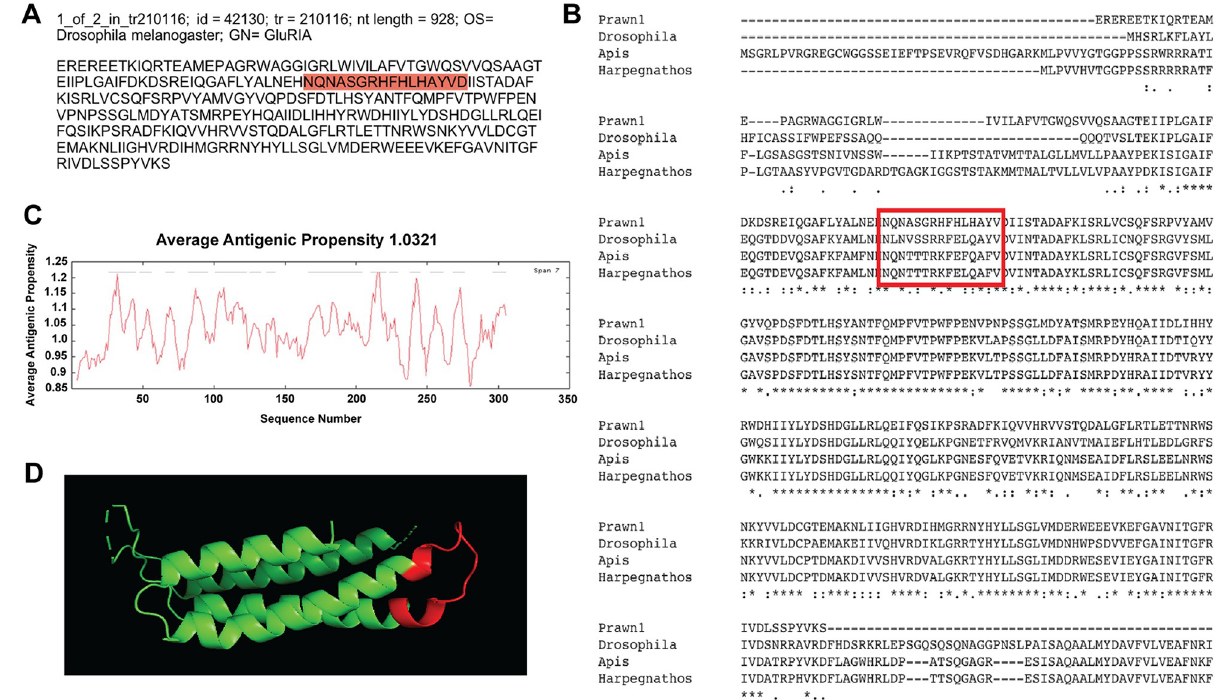
Fig 5. Contig annotated as ionotropic glutamate receptor A-1 (GluRIA-1) analysis for antibody production. A) Contig identifiers for GluRIA-1 in the M . carcinus transcriptome and its sequence translated into amino acids for further analysis. B) Multiple sequence alignments of the prawn´s contig were compared to the same protein in other species: the fruit fly D . melanogaster , European bee A . mellifera , and the Indian jumping ant H . saltator . Regions of conserved amino acids are shown within the red box. C) Average antigenic propensity value was 1.0321, showing 14 determinants (peaks in graph) within the sequence that are good candidates for antigenic response. D) A 3D reconstruction model showing tertiary structures of the prawn GluRIA-1 contig sequence. The red highlight in A, rectangle in B and segment in D represent the selected sequence for antibody production.